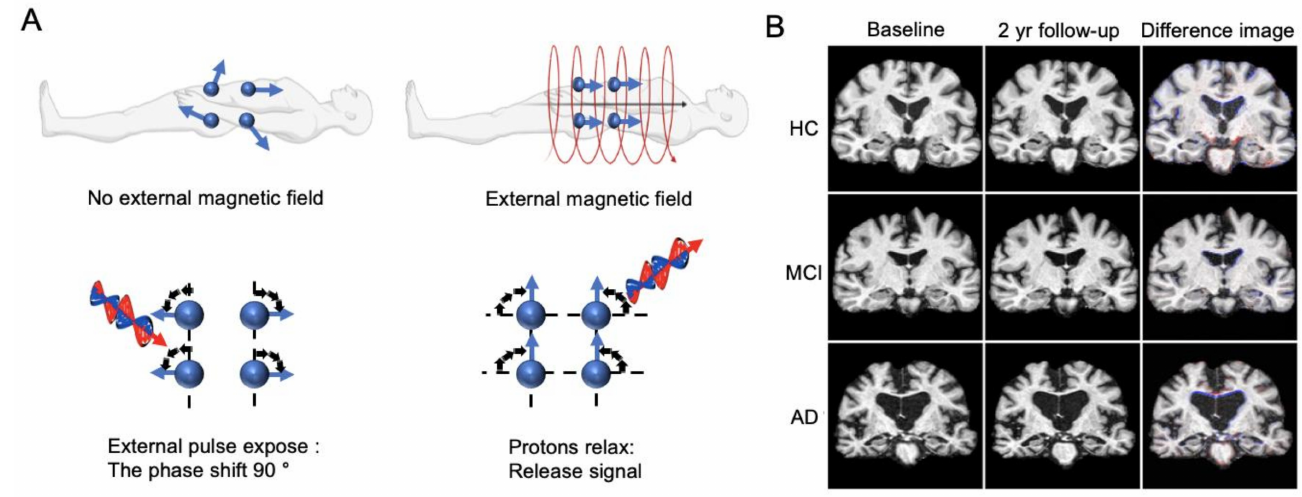
Figure 2. MR imaging. ( A ) Principles of MR imaging. ( B ) MR images of healthy control (HC) subject, mild cognitive impairment (MCI) subject who converted to AD after three years, and an AD patient. Adapted from [41] with permission from Springer